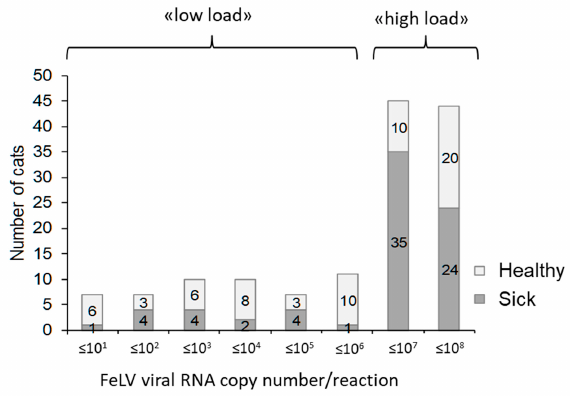
Figure 6. Distribution of salivary FeLV viral RNA loads in FeLV-positive healthy and sick cats. Loads are given as copies per PCR reaction conducted with 5 µL of total nucleic acid extracted from 100 µL of liquid from saliva swab samples.